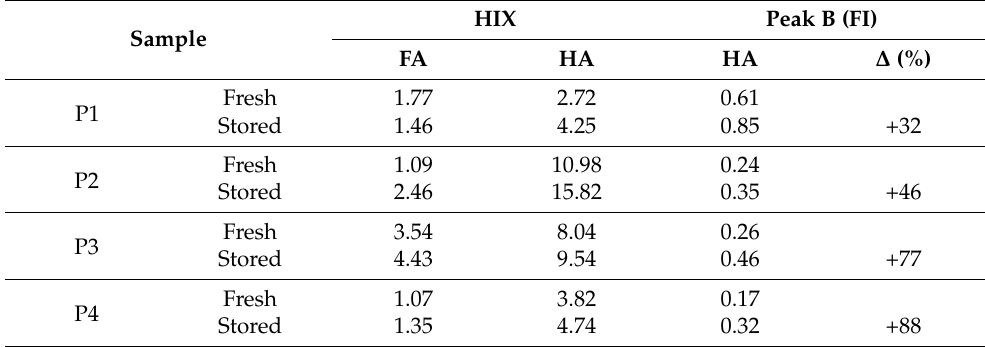
Table 4. Zsolnay humification index (HIX) of FA and HA and Peak B fluorescence intensity (FI) of HA extracted from fresh and stored sewage sludge samples.